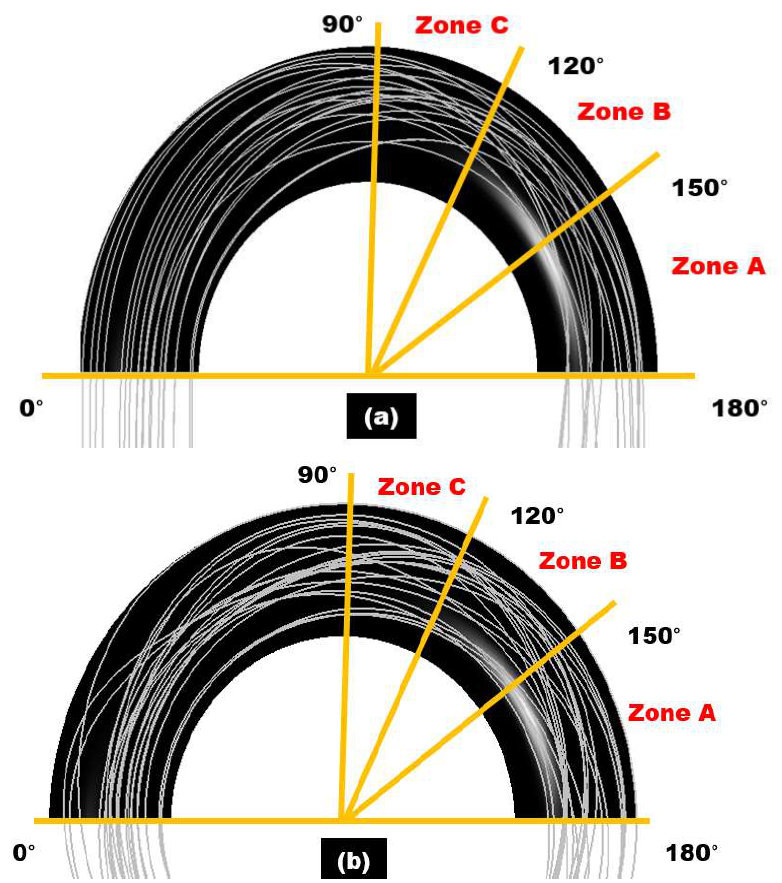
Figure 14. Trajectories of 250 µm sand particles under the particle velocity of 6 m/s: ( a ) 180° U−bend; ( b ) double offset U−bend.